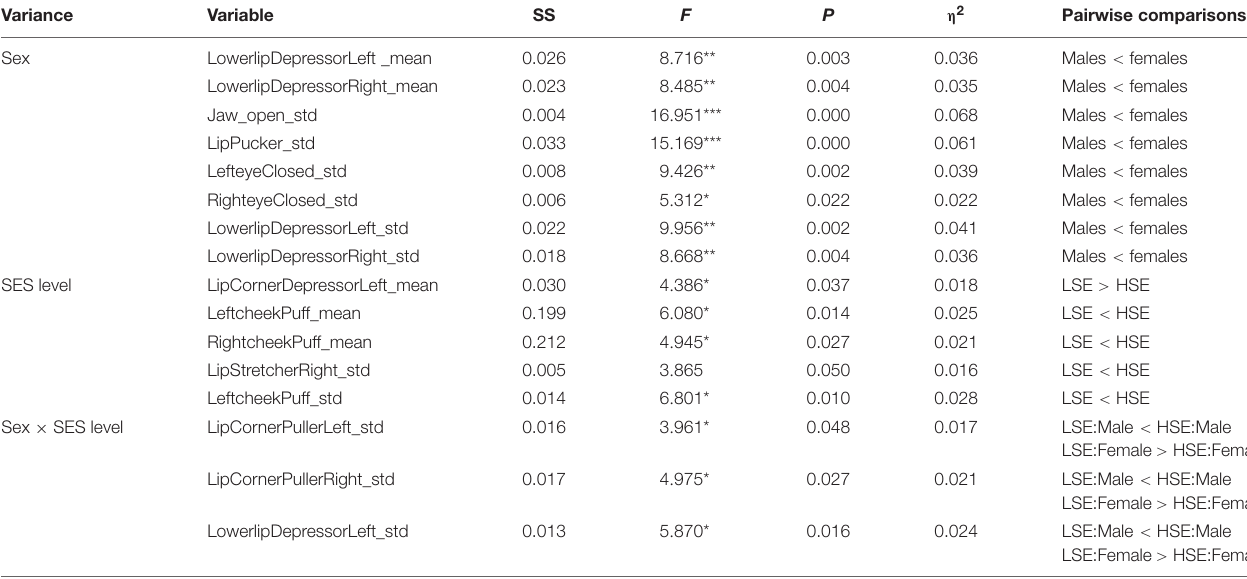
TABLE 3 | Significant results for two-way analysis of variance.